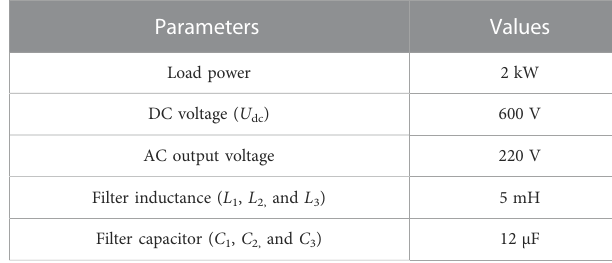
TABLE 4 Simulation